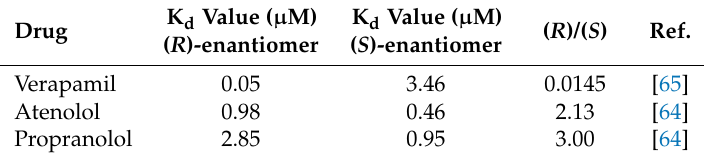
Table 3. K d values of each enantiomer of verapamil, atenolol, and propranolol for OCT1.